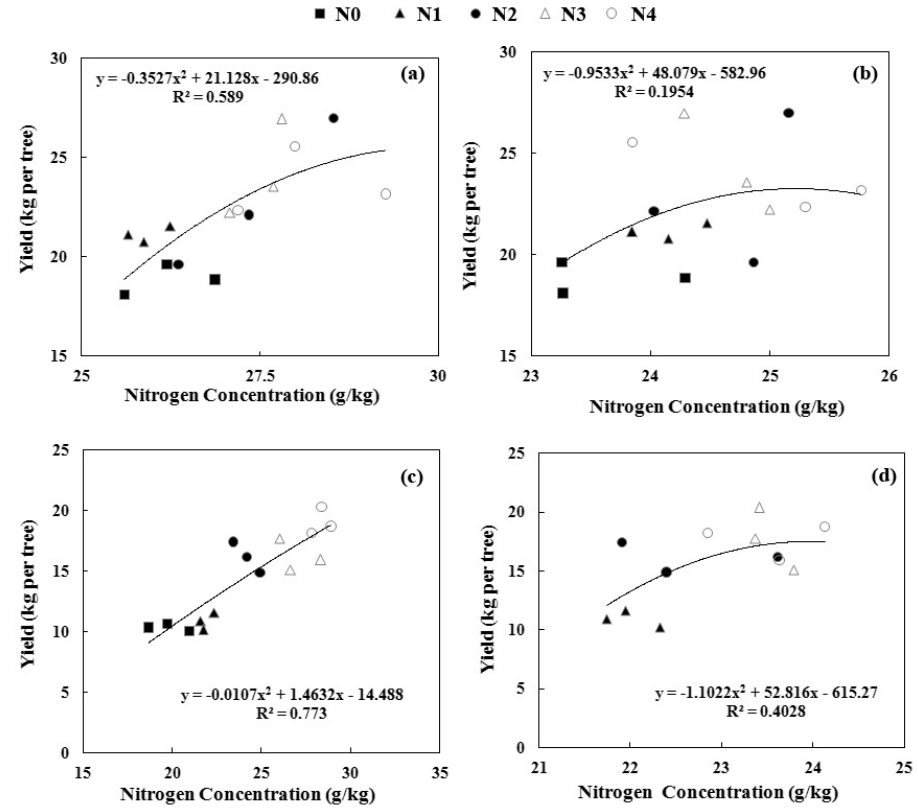
Figure 10. Relationship between the chemically-measured leaf N concentration and the fruit yield.